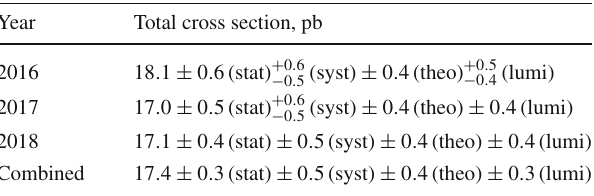
Table 4 Measured total σ( pp → ZZ ) cross section for each data sam- pleandcombined.Thefirstuncertaintyisstatistical,thesecondisexper- imental systematic, the third is theoretical systematic. The fourth uncer- tainty is associated with the integrated